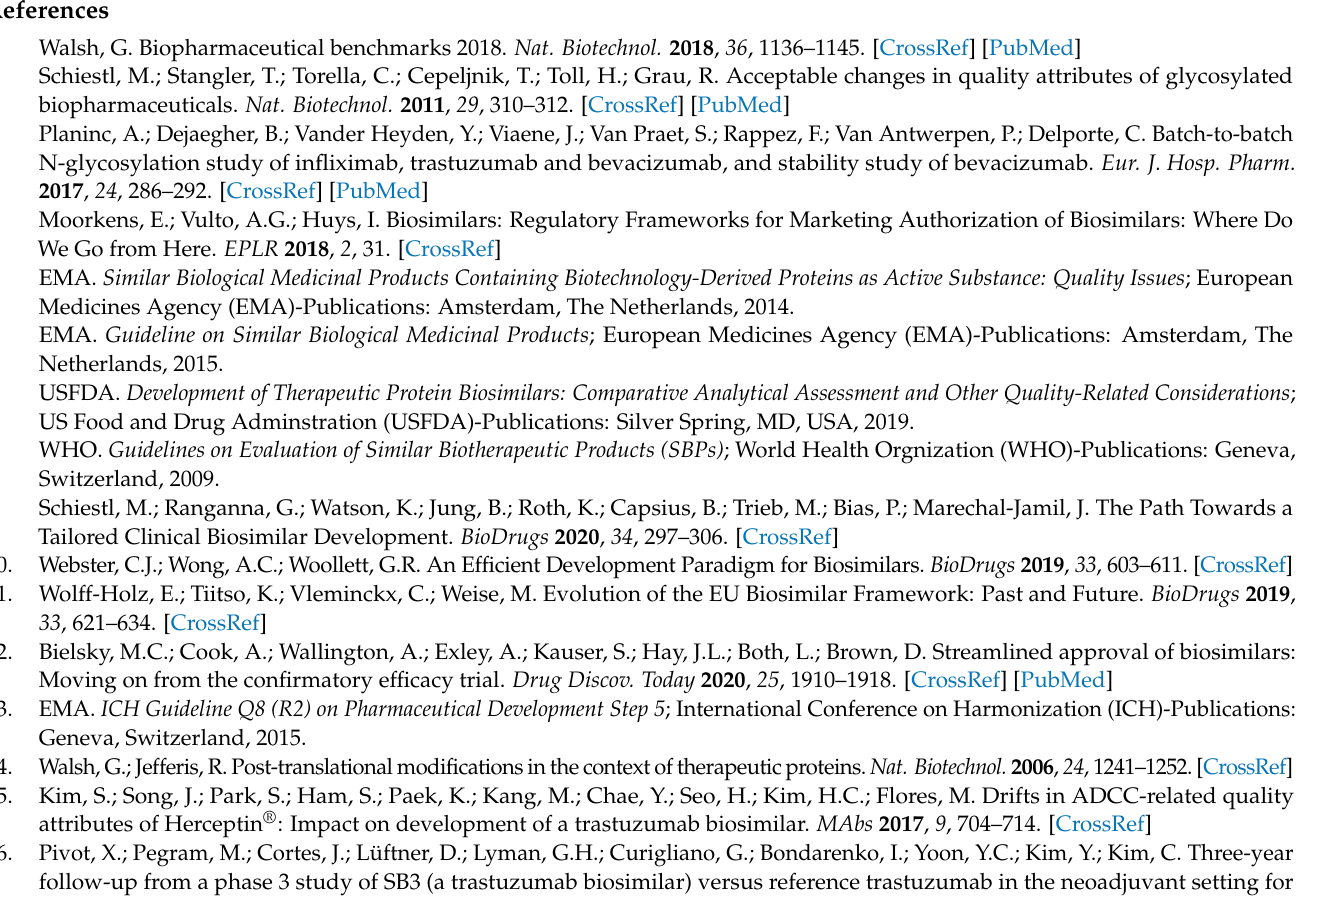
(EPARs); Table S2: Comparison of potentially critical quality attributes (pCQAs) where test results and interpretation were reported for ABP501 and MSB11022